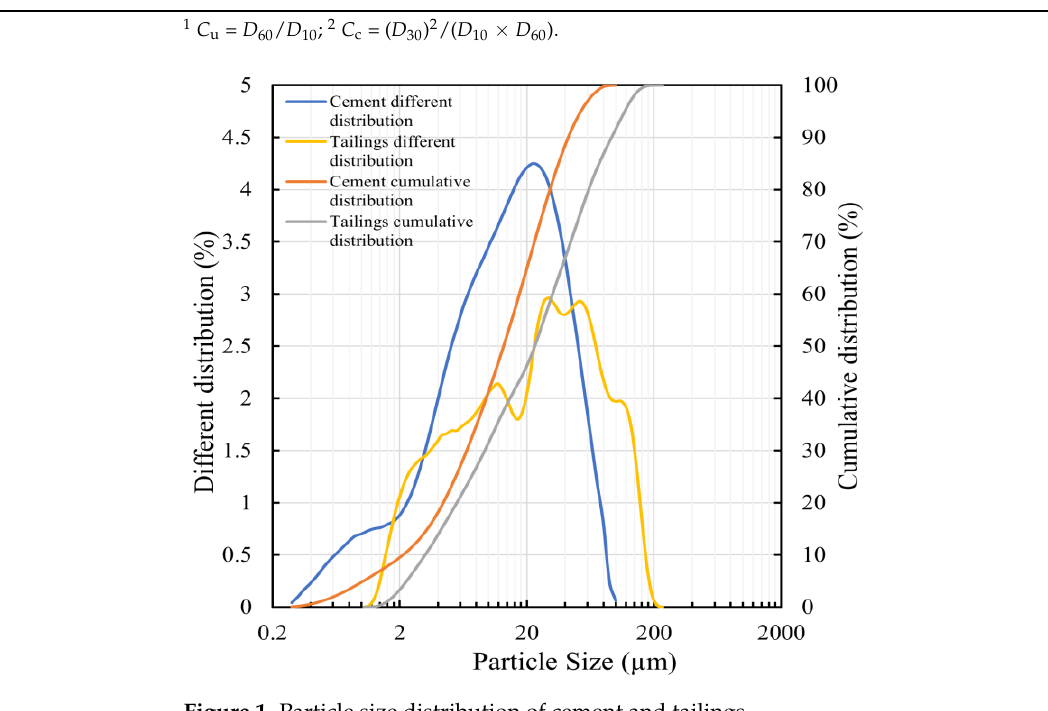
Figure 1. Particle size distribution of cement and tailings. Table 2. Main composition of cement and tailings.